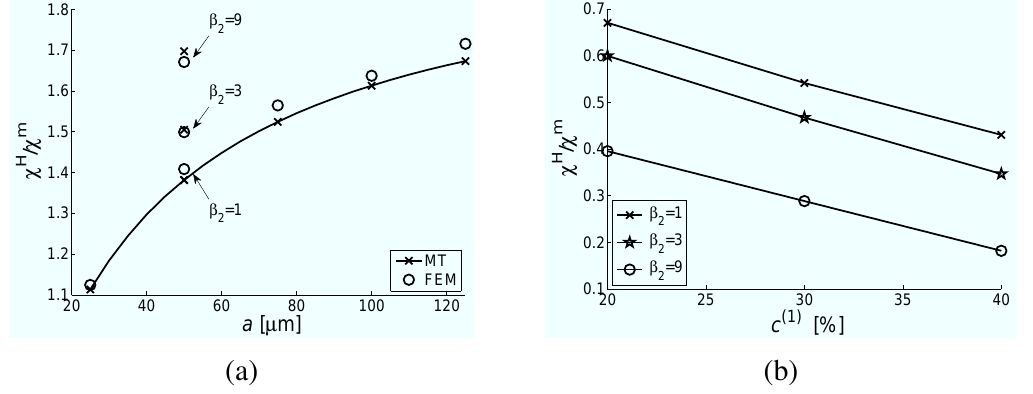
Figure 10. ( a ) Variation of normalized effective conductivity χ H /χ m for a system with imperfect interface ( k = 60 × 10 6 Wm − 2 K − 1 and χ (1) = 100 Wm − 1 K − 1 , χ m = 10 Wm − 1 K − 1 and c (1) = 40% ) as a function of inclusion radius a and ( b ) variation of effective conductivity for systems weakened by cylindrical voids as a function of inclusion volume fraction c (1) ; β denotes inclusion aspect ratio. 2